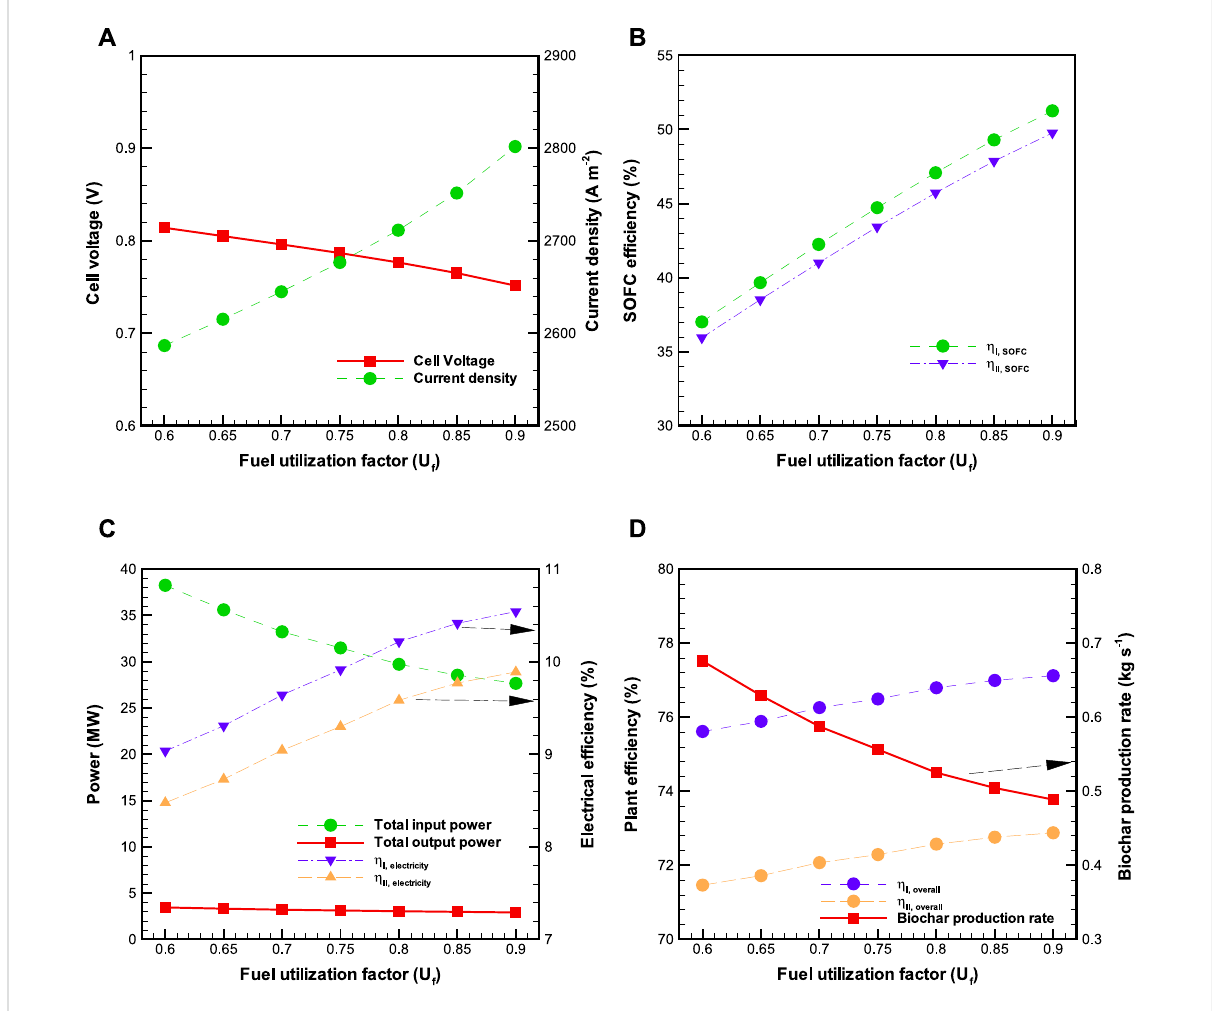
FIGURE 5 Effectsoffuelutilizationfactor( U f )ontheBP-SOFC-CHPsystem: (A) SOFCcellvoltageandcurrentdensity, (B) SOFCef fi ciency, (C) totalpower input and output and electrical ef fi ciency, and (D) overall system ef fi ciency and biochar production